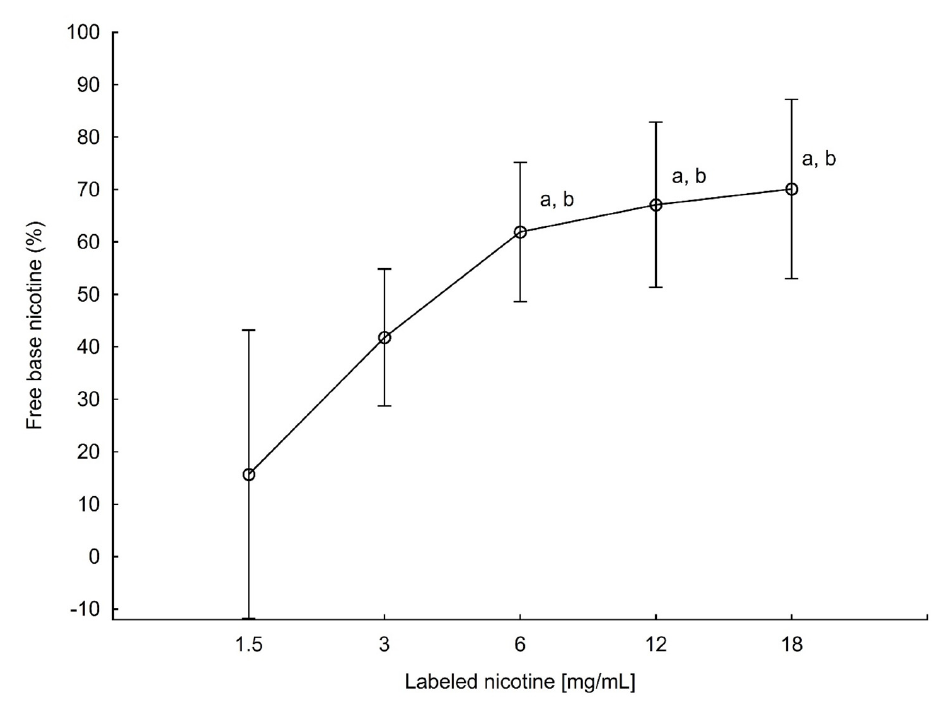
Figure 3. Differences in freebase nicotine content between different labeled nicotine concentrations.